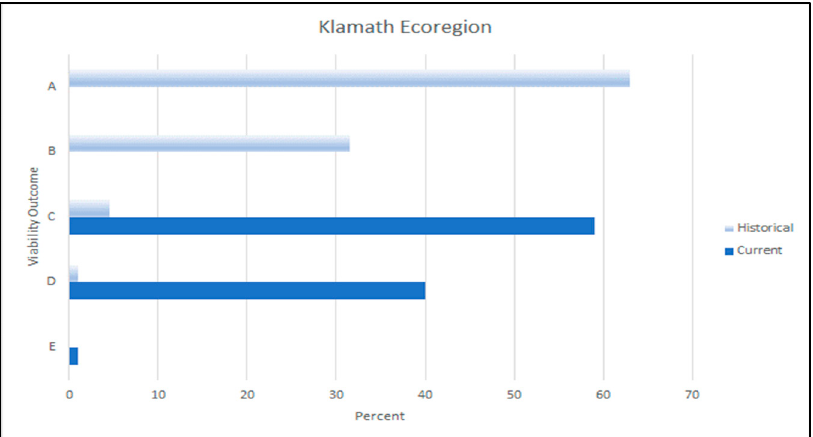
Figure 10. Historical (light blue bar) and current (dark blue bar) viability outcomes for red tree voles ( Arborimus longicaudus ) in the Klamath Mountains ecoregion in Oregon and California, USA. Viability outcomes are described in Table 4.